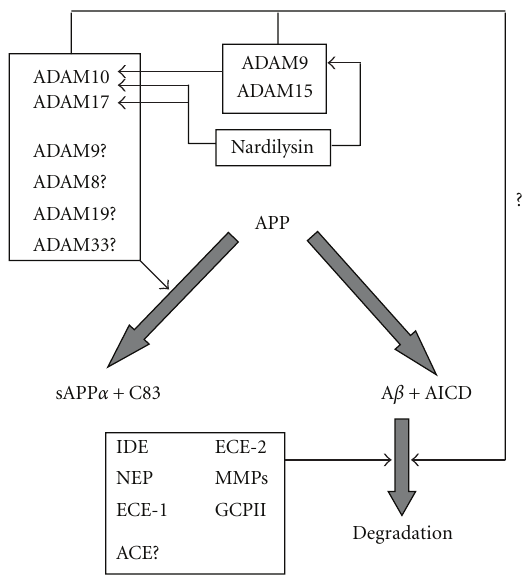
Figure 4: The involvement of zinc metalloproteinases in A β metabolism. A range of ADAMs (10, 17, 9, 8, 19, and 33) have been implicated in the nonamyloidogenic processing of APP to generate sAPP α and C83, although the evidence for the latter four enzymes having a direct physiological role in this respect is limited. ADAMs 9 and 15 are capable of cleaving ADAM10 and may be indirectly involved in the activation of the nonamyloidogenic pathway in this respect. Nardilysin also indirectly activates nonamyloidogenic processing of APP via an activation of ADAMs 9, 10, and 17. IDE, NEP, ECE-1, ECE-2, MMPs, GCPII and, possibly, ACE are involved directly in the degradation of A β , and a potential role for catalytically active ADAMs in the degradation of A β remains to be